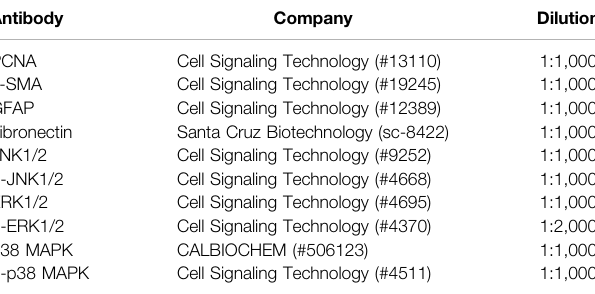
TABLE 2 | Primary antibody used for Western blotting